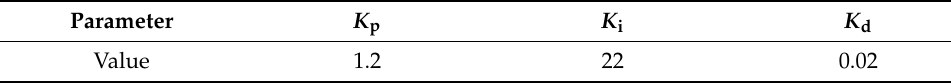
Figure 10. PLCs and AC Drivers in Water Treatment System. ( a ) PLCs in Water Treatment System. ( b ) AC Drivers in Water Treatment System. Table 4. Parameter Values of the PID